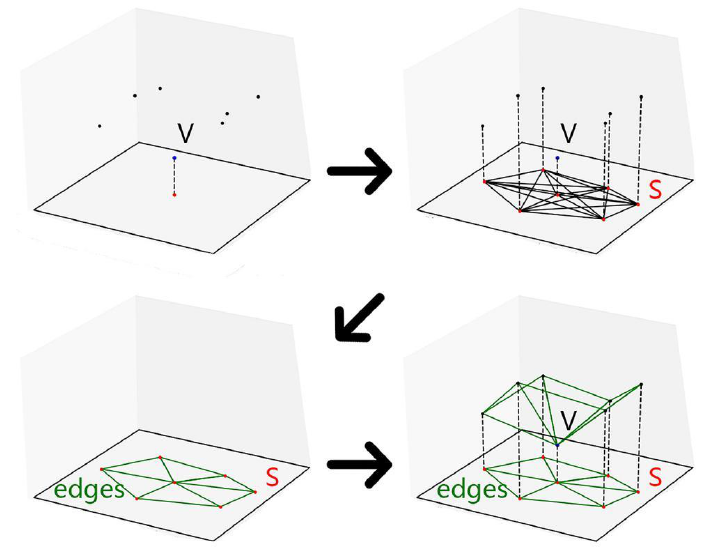
Figure 2. Greedy projection triangulation schematic.